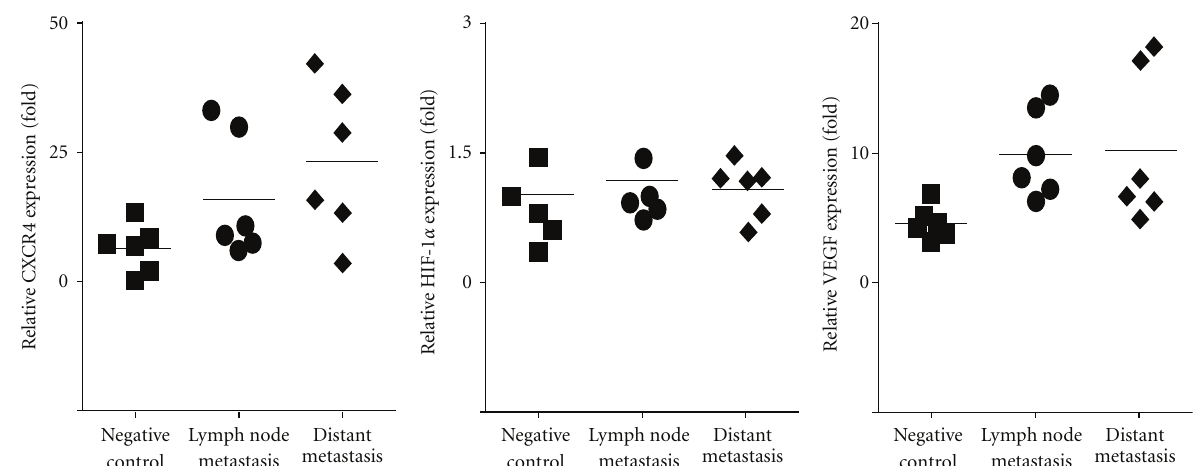
Figure 3: Expression of HIF-1 α , CXCR4, and VEGF mRNA in normal colon tissues and colon cancer. The mRNA expression of HIF-1 α , CXCR4, and VEGF were quantified by real-time PCR in di ff erent samples, including normal colonic tissue samples ( n = 6, negative control group), colon cancer with lymph node metastasis samples ( n = 6, lymph node metastasis group), and colon cancer with distant metastasis samples ( n = 6, distant metastasis group). Total RNA was isolated using TRIzol according to the manufacturer’s instructions and reverse transcribed. mRNA expression of HIF-1 α , CXCR4, VEGF and β actin was determined by real-time PCR using SYBR Green master mix (see Section 2). Di ff erences in the relative level of three markers normalized to β actin can be estimated by di ff erences in the ratio. CXCR4, 15.91 ± 12.14-fold in lymph node metastasis group or 23.20 ± 14.84-fold in distant metastasis group versus 6.23 ± 4.66-fold in negative control group, respectively, P < . 05, VEGF, 9.99 ± 3.38-fold in lymph node metastasis group or 10.27 ± 5.90-fold in distant metastasis group versus 4.68 ± 1.28-fold in negative control, respectively, P < .